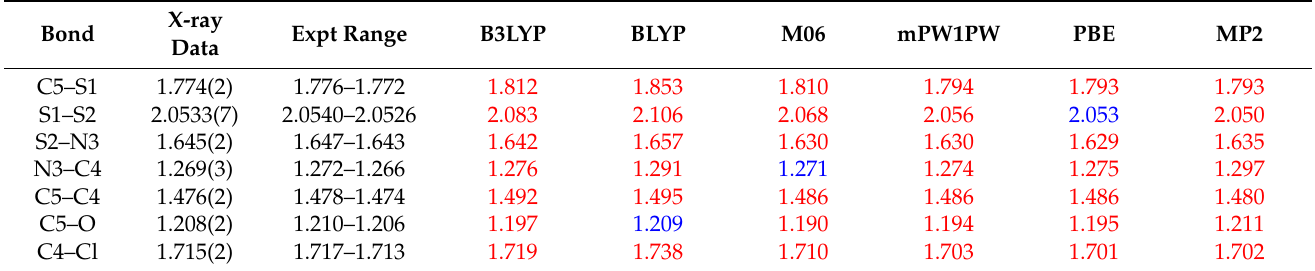
Table 3. Experimental and computational bond lengths (Å) of the dithiazolone 2b a .